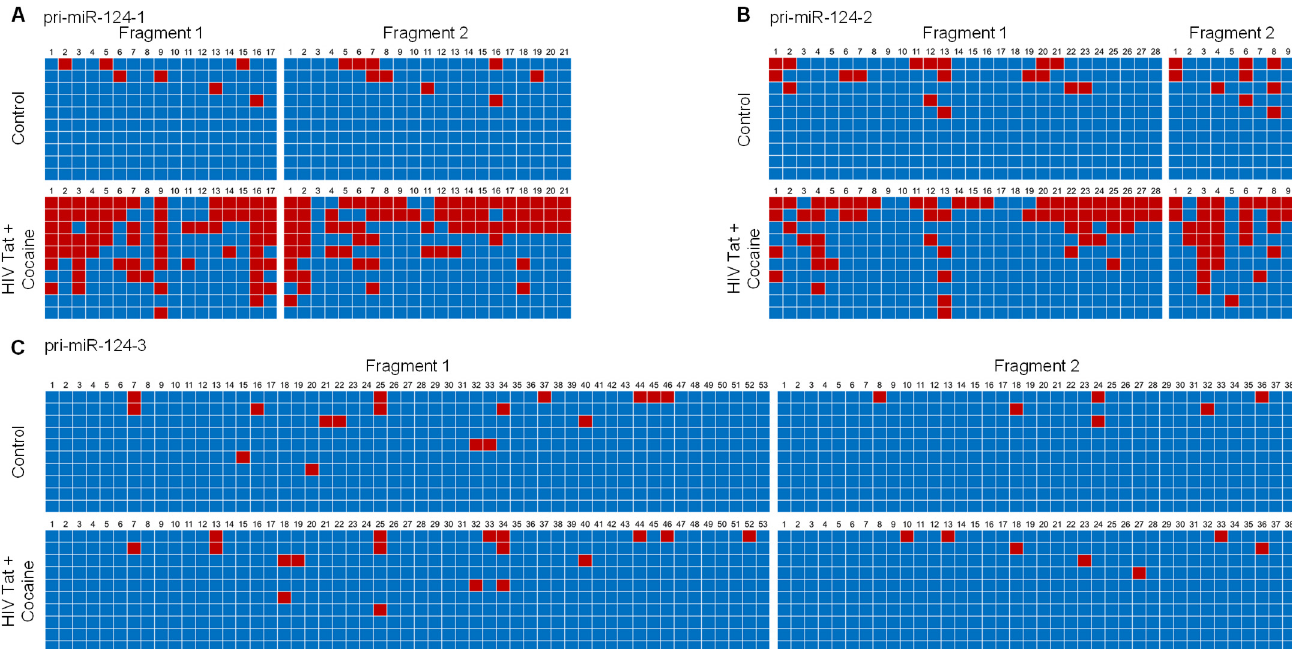
Figure 3. HIV-1 Tat and cocaine significantly increased the DNA methylation levels in primary miR-124-1 and -2, in microglia. Promoter DNA methylation of pri-miR-124-1 ( A ), prim-miR-124-2 ( B ), and pri-miR-1244-3 ( C ), using bisulfite-converted genomic DNA sequencing in HIV-1 Tat (25 ng/mL)- and cocaine (10 μ M)-exposed mouse primary microglial cells. The promoter methylation status of sequenced data was analyzed using default threshold settings by BISMA software (http://services.ibc.uni-stuttgart.de/BDPC/BISMA, accessed on 25 July